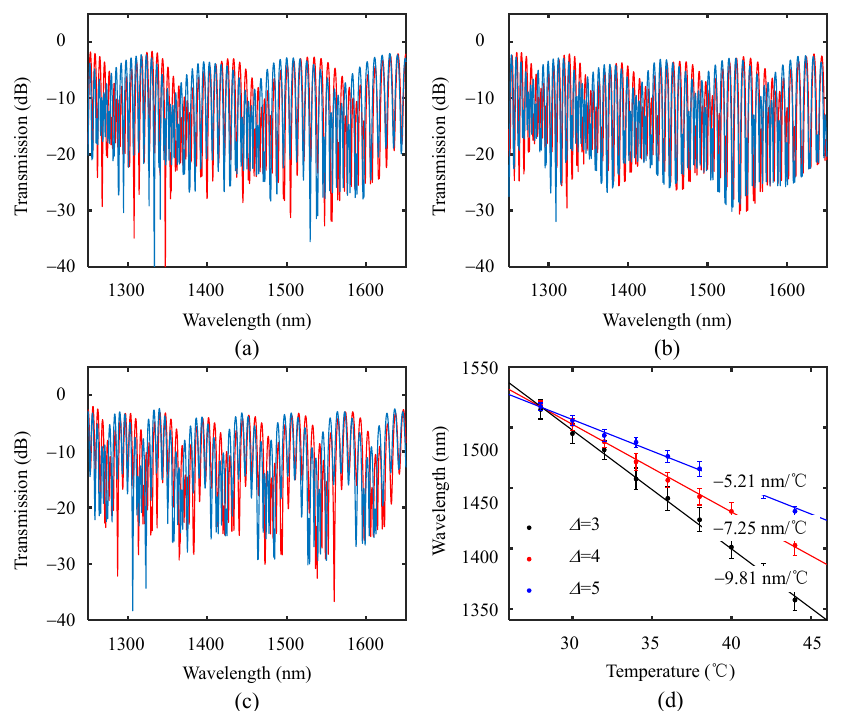
Fig. 6 Transmission spectra with different values of  : (a)  = 3 cm, (b)  = 4 cm, and (c)  = 5 cm (Red line: transmission spectra at 30 ℃ ; blue line: transmission spectra at 32 ℃ ); (d) temperature sensitivity corresponding to different